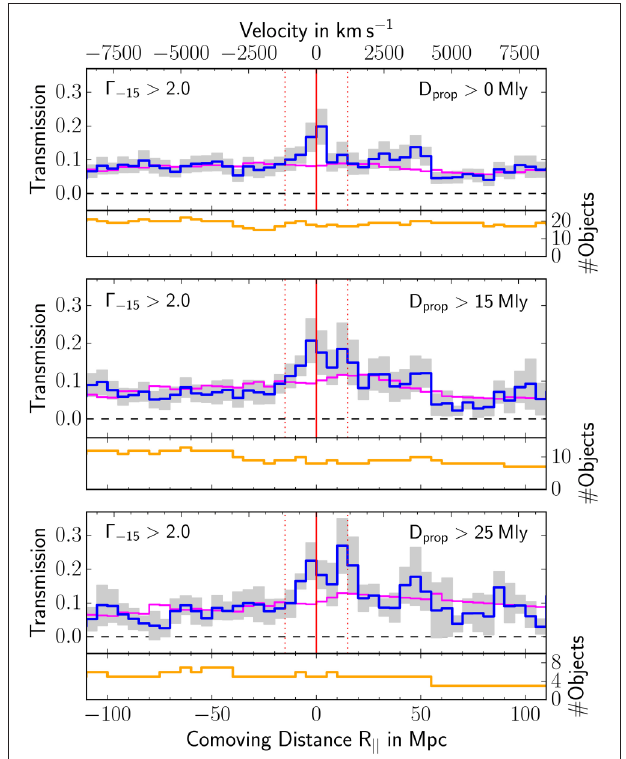
FIGURE 3 | Statistical detection of the He II transverse proximity effect from Schmidt et al. (2017). We compute an average He II transmission profile in the vicinity of the foreground quasars (blue) by stacking the He II spectra on the positions of known foreground quasars. Bootstrap errors are given in gray, the number of contributing objects in yellow. The purple line shows a simple model for the average He II transmission in the IGM. The top plot includes all quasars with Ŵ HeII QSO > 2 × 10 − 15 s − 1 and shows a clear transmission enhancement at the position of the foreground quasars (red). The other two plots include only a subset of foreground quasars with a minimum separation from the background sightline larger than 15 and 25Mlyr. The transmission enhancement persists in these stacks, setting a clear constraint on the age of the foreground quasars. © : AAS. Figure reproduced from Schmidt et al.